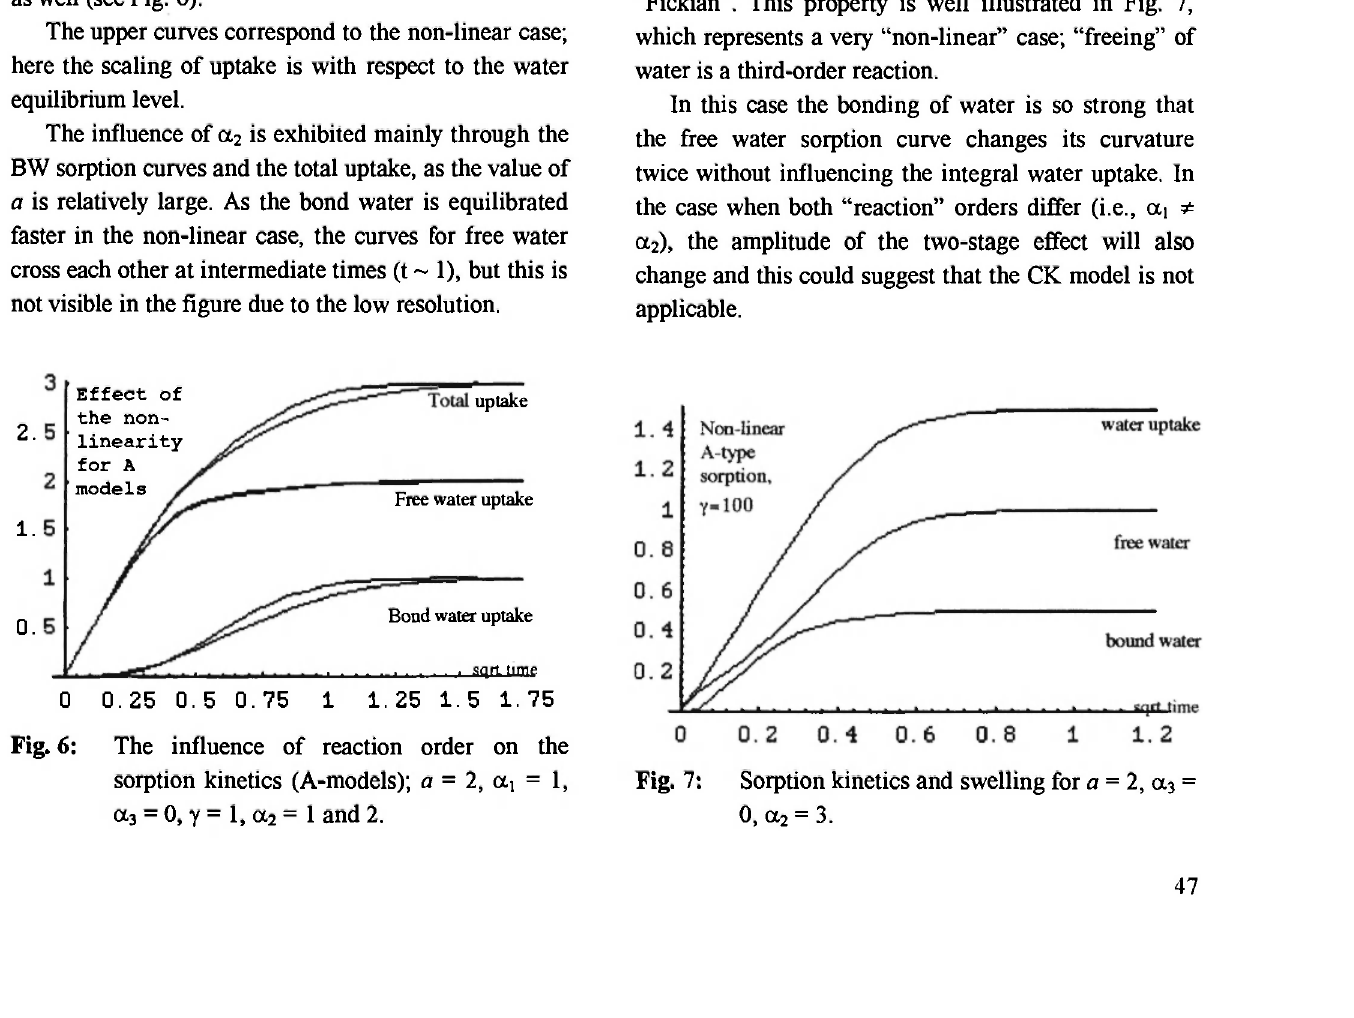
Fig. 7: Sorption kinetics and swelling for a = 2, a 3 = 0, a 2 =